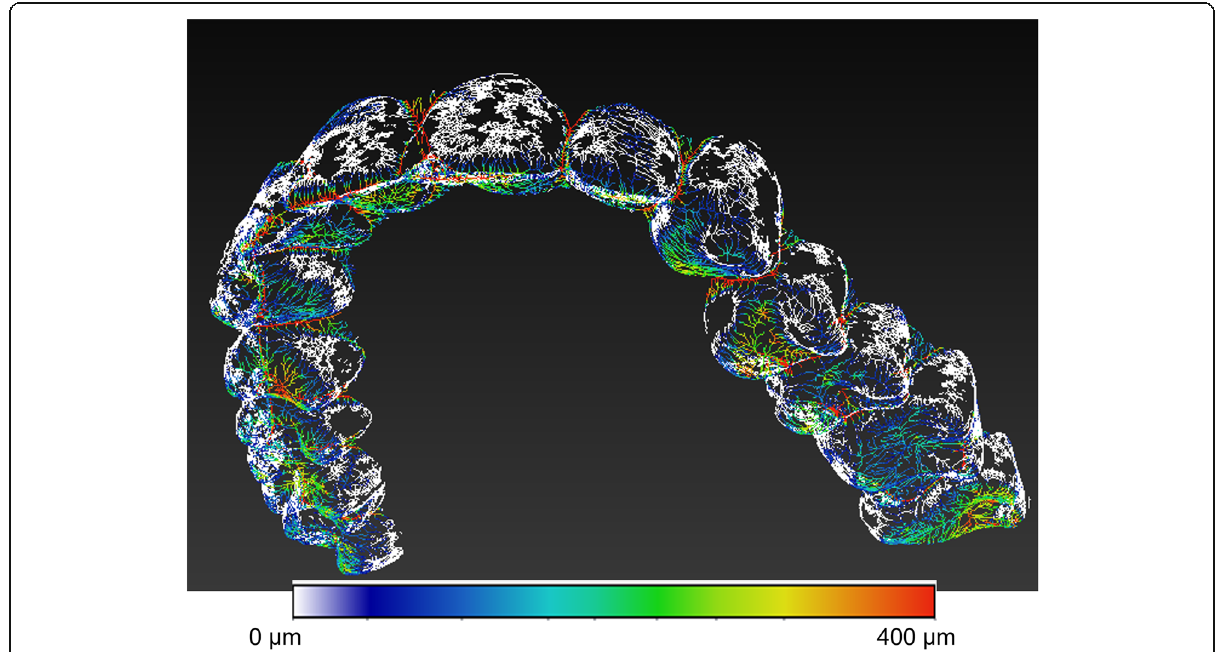
Fig. 1 Skeleton colourimetric mapping of the distances measured. White dots indicate a minimum distance of 15 μ m, and red dots greater than